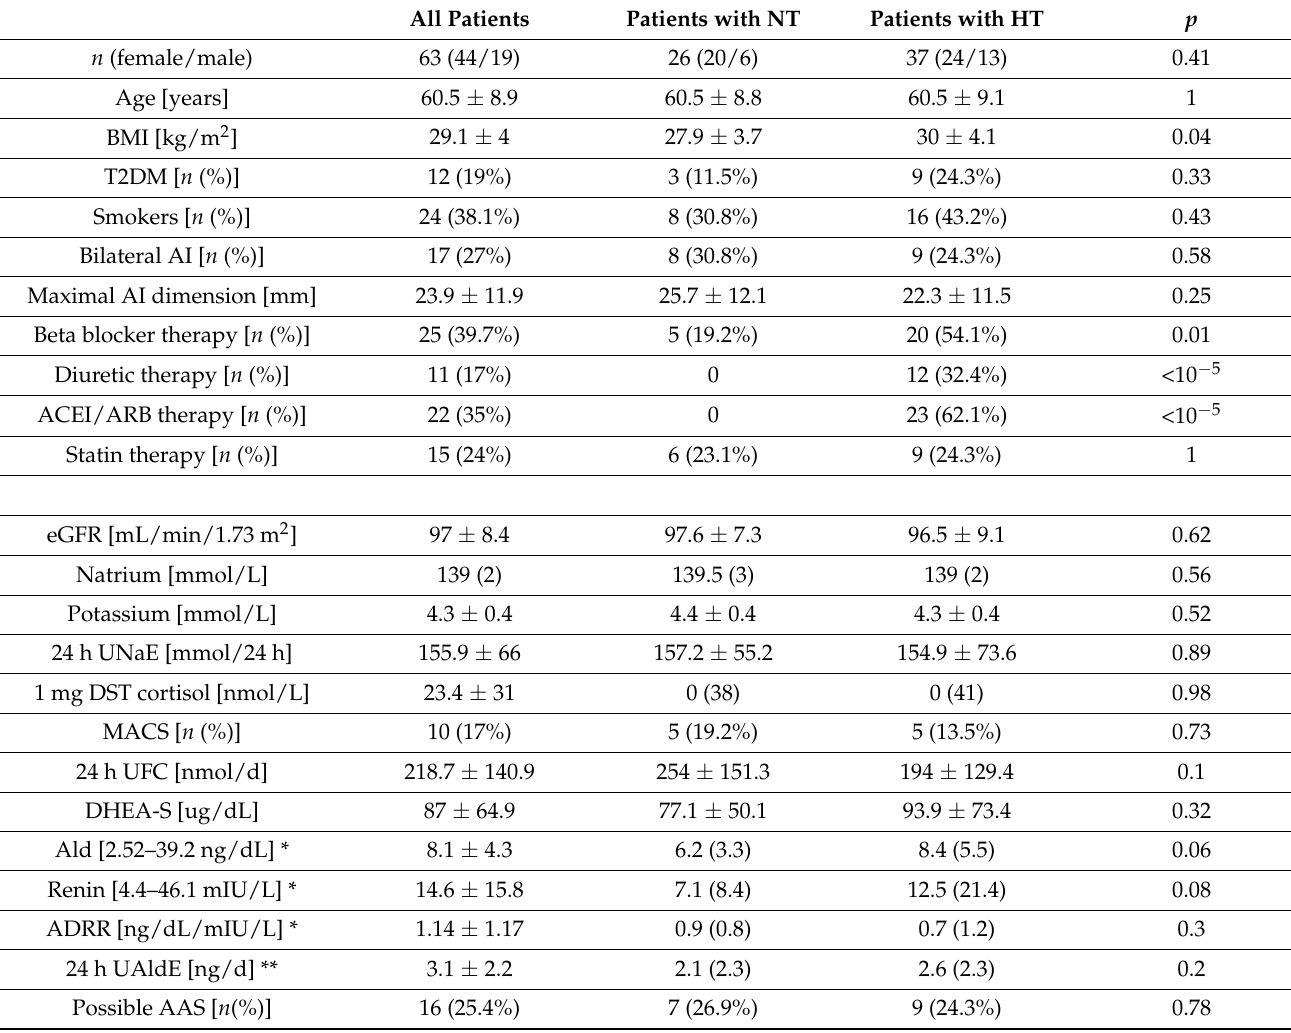
Table 1. Clinical and laboratory